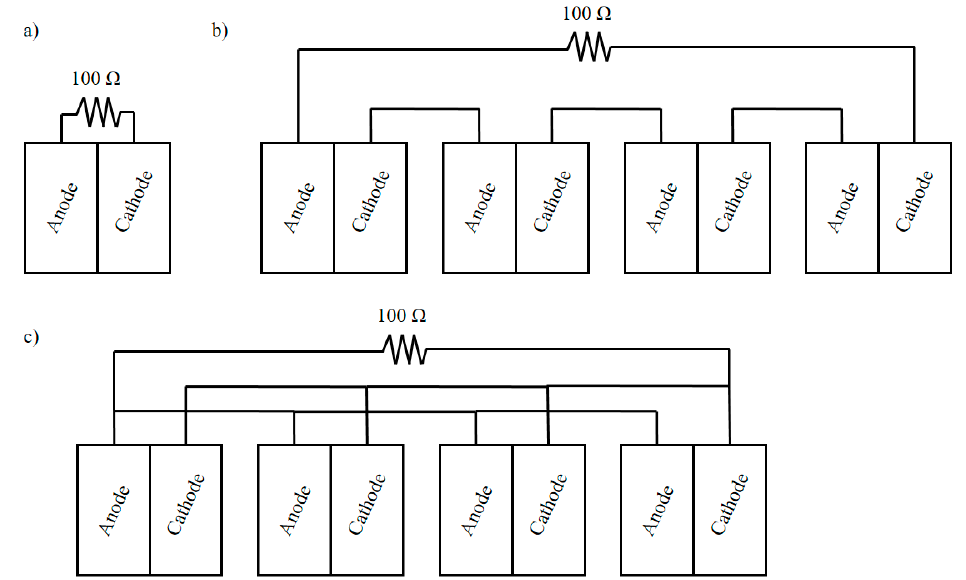
Figure 7. Units’ connection ( a ) in batch mode, ( b ) continuous operation in series connection and ( c ) continuous operation in parallel connection.